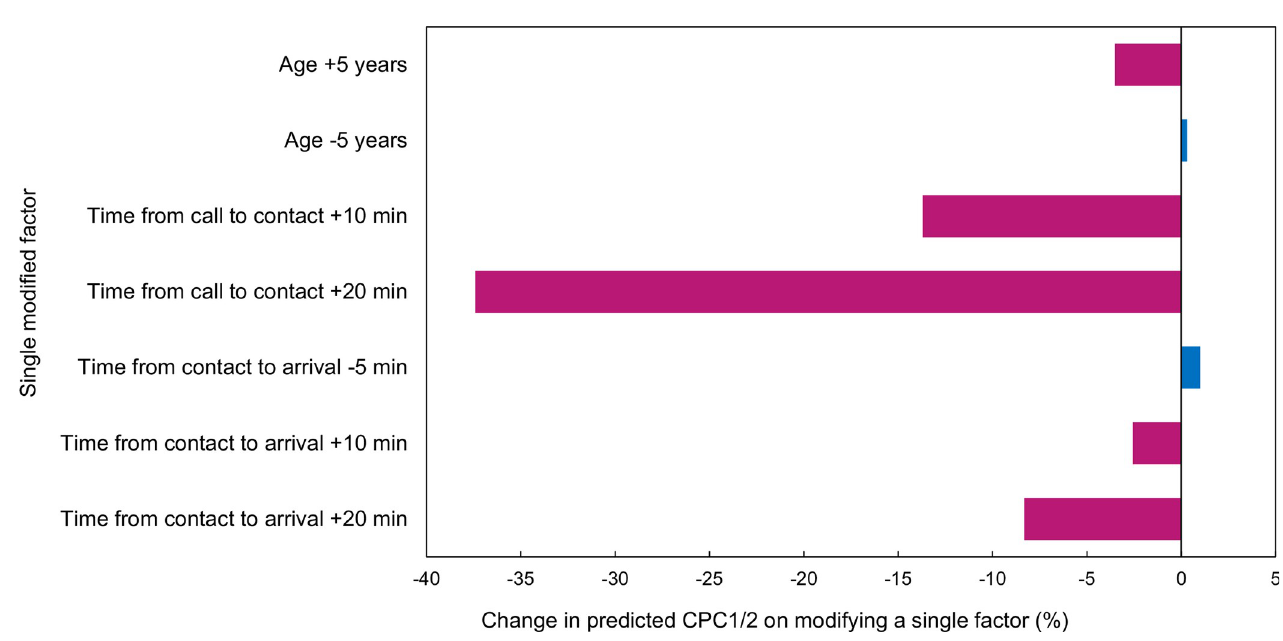
Fig 3. Modification of single factors changes the predicted CPC1/2. Changes in predicted outcome obtained by modifying a single factor. A higher age worsened the prognosis, and vice versa. Time delay worsened the prognosis, whereas reducing the duration improved the prognosis. CPC, cerebral performance